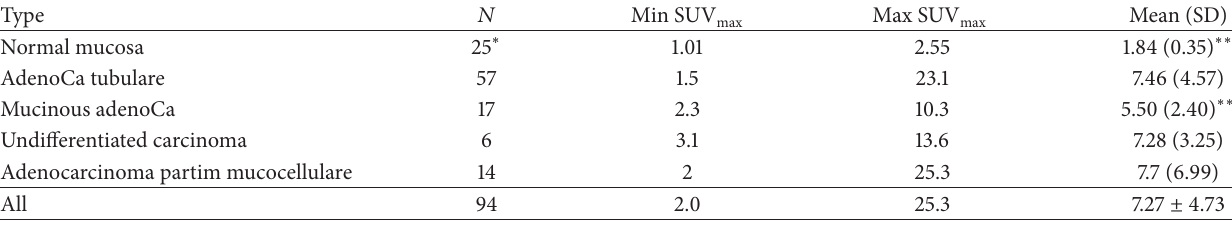
(SD) in normal mucosa and different cancer types. max